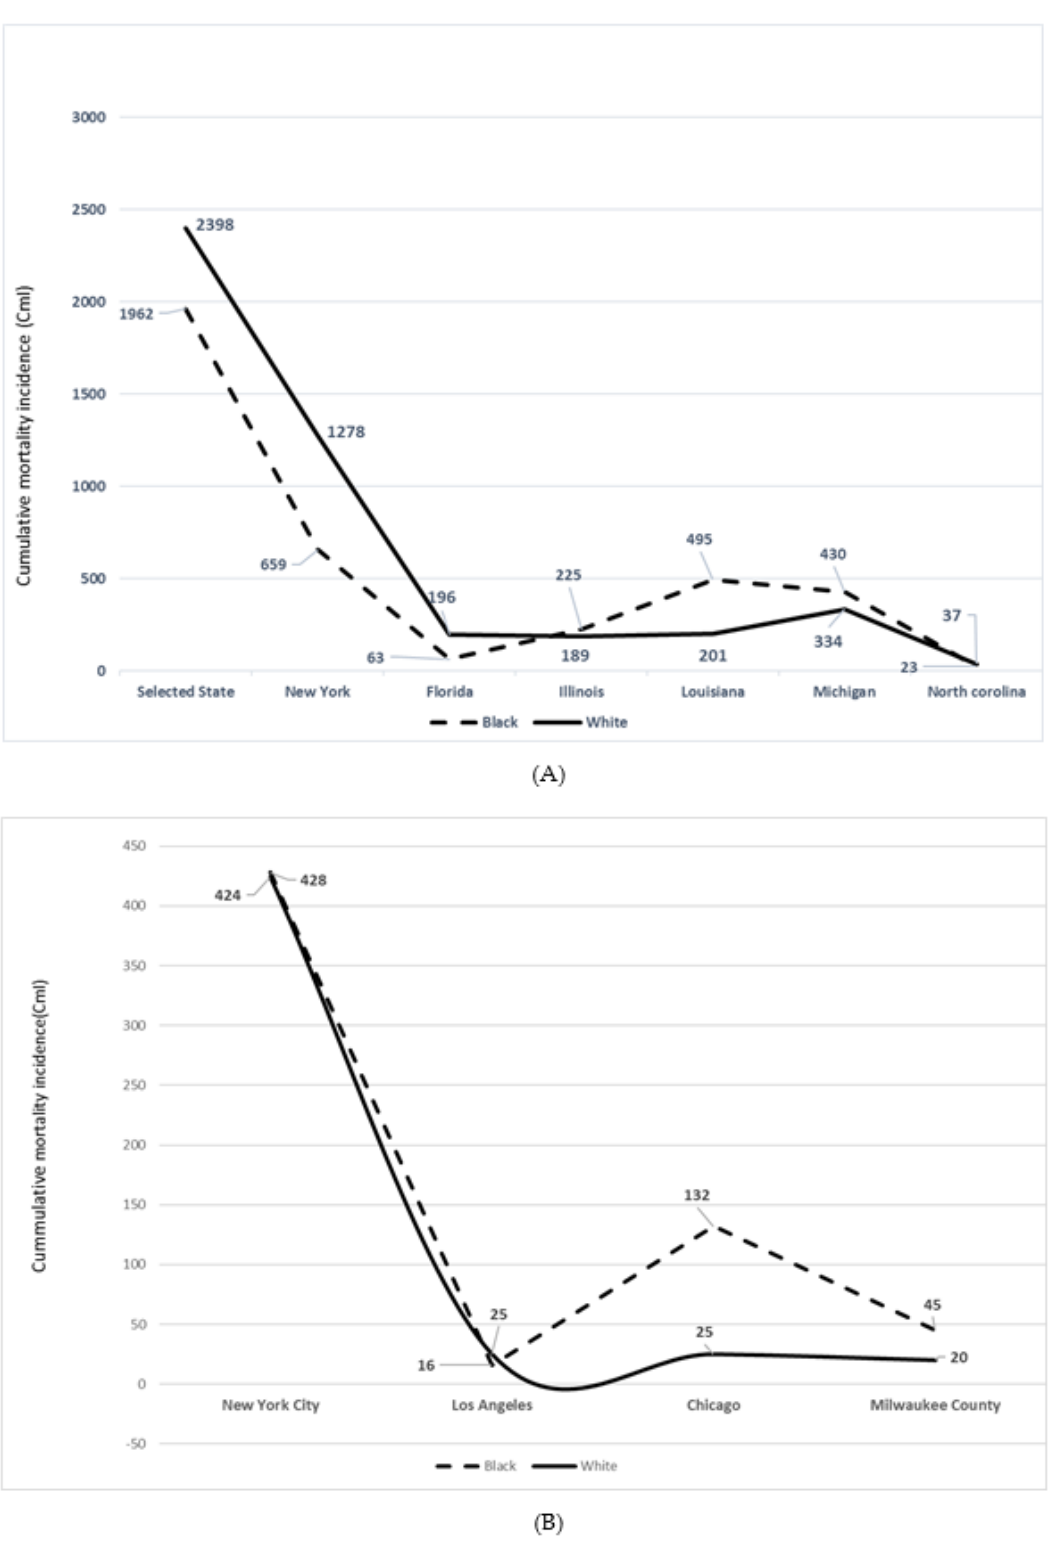
Figure 1. ( A ) Frequency of COVID-19 mortality by race in selected states, USA, 9th April 2020. Notes. The COVID-19 mortality frequency reflects higher occurrence in Illinois, Louisiana, Michigan and North Carolina. ( B ) The frequency of COVID-19 mortality by race in selected cities and Milwaukee County, USA, 9th April 2020. The cities with the disproportionate burden of COVID-19 for Blacks are Chicago and Milwaukee city as well as the county.